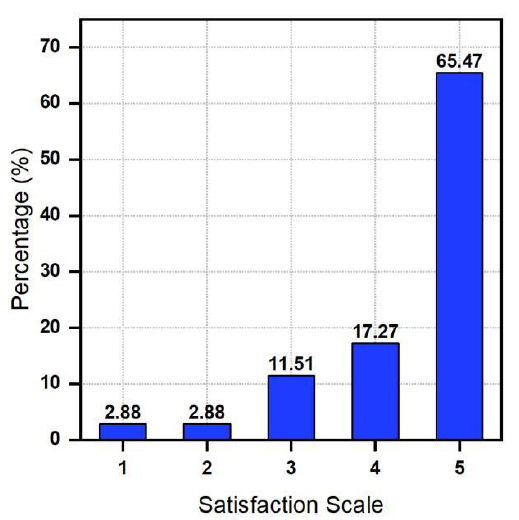
Figure 10. Relative humidity satisfaction vote.